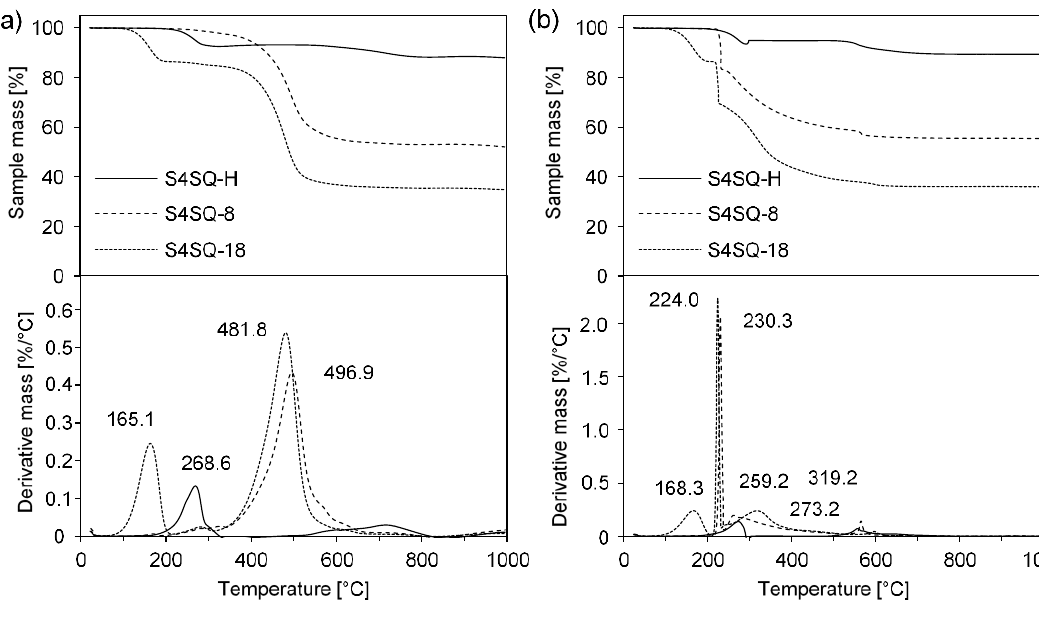
Figure 1. Thermogravimetry (TG)/derived thermogravimetry (DTG) curves of neat siloxane-silsesquioxane (S4SQ) resins ( a ) under nitrogen and ( b ) in air atmosphere.